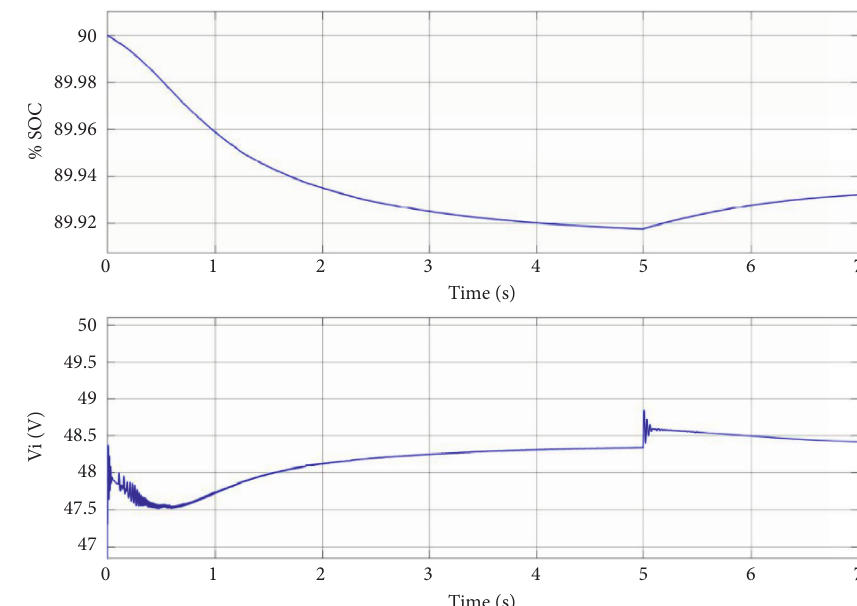
Figure 14: Battery voltage and % SOC during motoring and regenerative